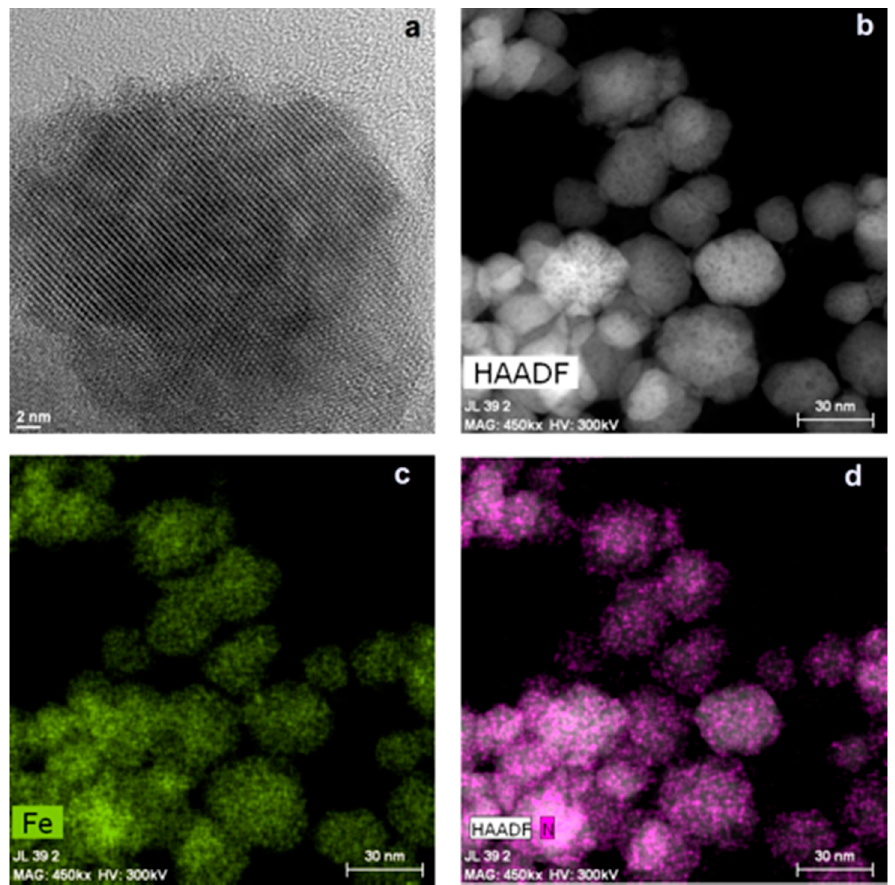
Figure 1. HRTEM ( a ) and high-angle annular dark-field (HAADF) images of MNP-1 ( b ), showing the distribution of Fe ( c ) and N ( d ) atoms.